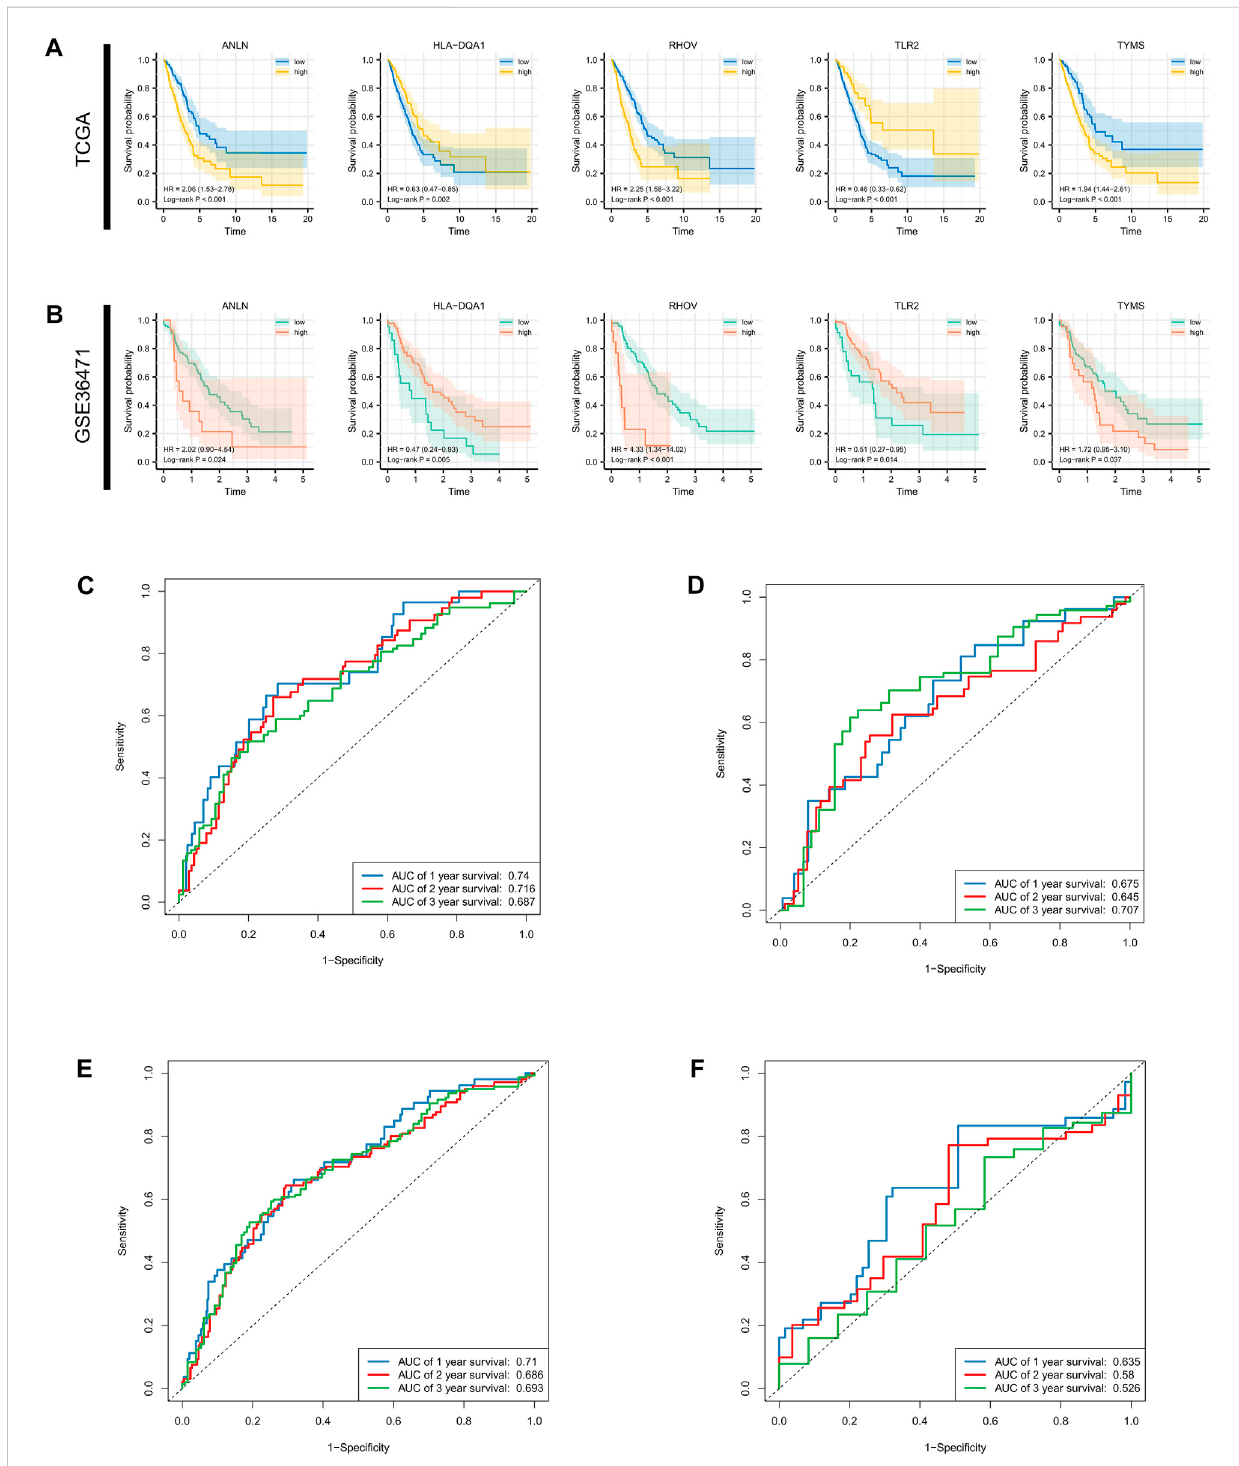
FIGURE 5 SurvivalanalysisforsinglegeneandAUCestimation.Survivaldifferencesevaluatedbylog-ranktestbetweenthelow-andhigh-expressiongroupsat the optimal cutoff of each optimal prognostic signature in the (A) entire TCGA cohort and (B) GSE36471. (C – F) 1-, 3-, and 5-year receiver operating characteristic curves and AUCs in the training set validation set, TCGA cohort, and GSE36471. AUC: area under the curve; TCGA: The Cancer Genome